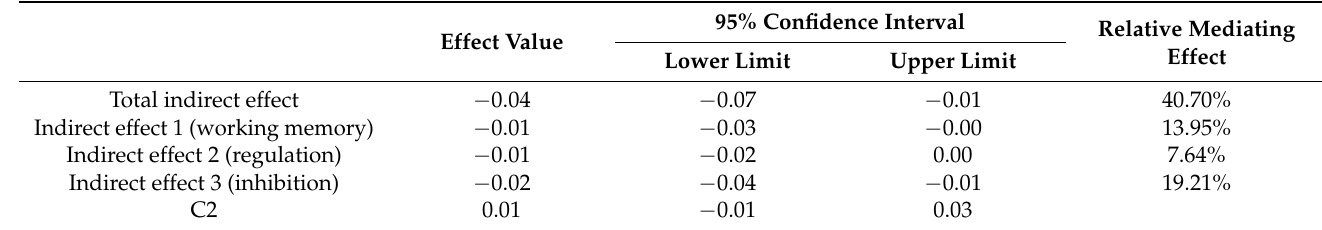
Table 5. The analysis of the mediating effects for each dimension of EF. Effect